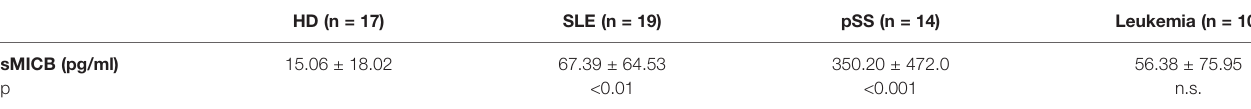
TABLE 2 | Comparison of sMICB concentrations in the serum of healthy individuals and different patient groups.